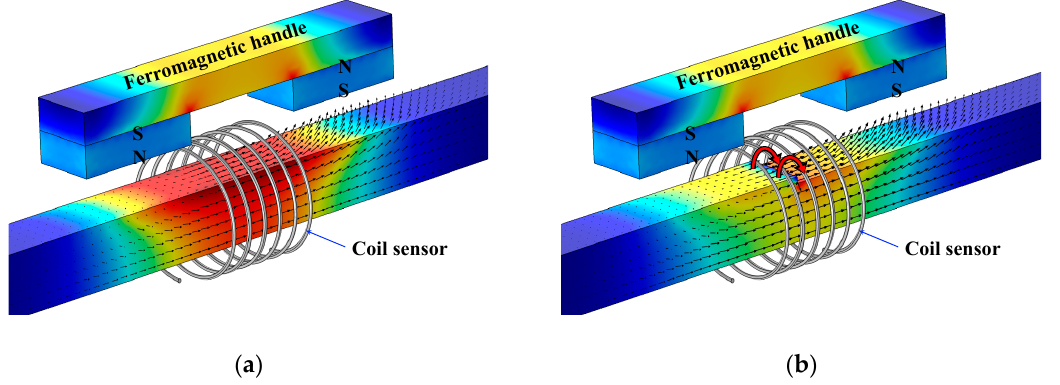
Figure 1. Magnetic flux leakage (MFL) phenomenon: ( a ) flawless specimen; ( b ) defected specimen. Governing